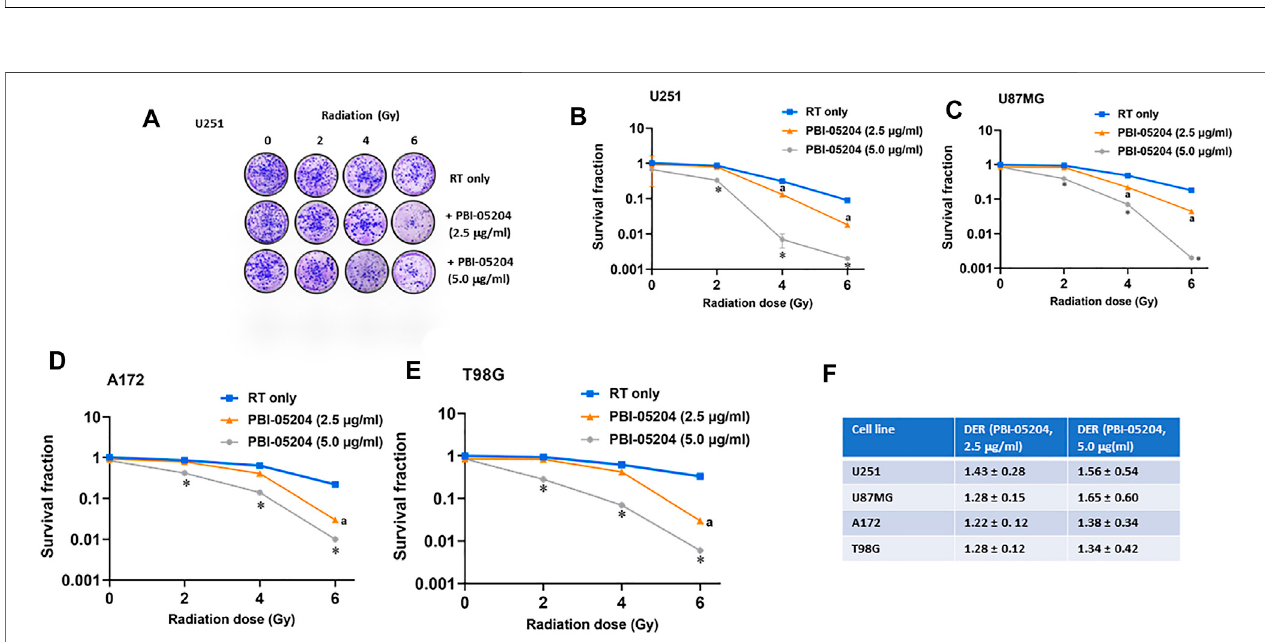
FIGURE2| LongtermeffectsofPBI-05204onradio-sensitivityofGBMcells.CellsweretreatedwithPBI-05204(2.5and5.0 μ g/ml)for24 hbeforeirradiation,then trypsinized and plated for clonogenic assay. Colonies were counted after 21 days and survival curves were constructed after normalizing for cytotoxicity induced from PBI-05204 alone. (A) Crystal violet staining of colonies from clonogenic assay in U251 cell lines. (B – E) Graphical representation of clonogenic assays of U251, U87MG, A172 and T98G GBM cells. Data are presented as mean ± SD ( n = 4). a p < 0.05 comparison between PBI-05204 (2.5 μ g/ml) + RT and RT only; * p < 0.05 comparison between PBI-05204 (5.0 μ g/ml) + RT and RT only. (F) Radiation Enhancement Ratio (DER) of PBI-05204 in aforementioned GBM cells.